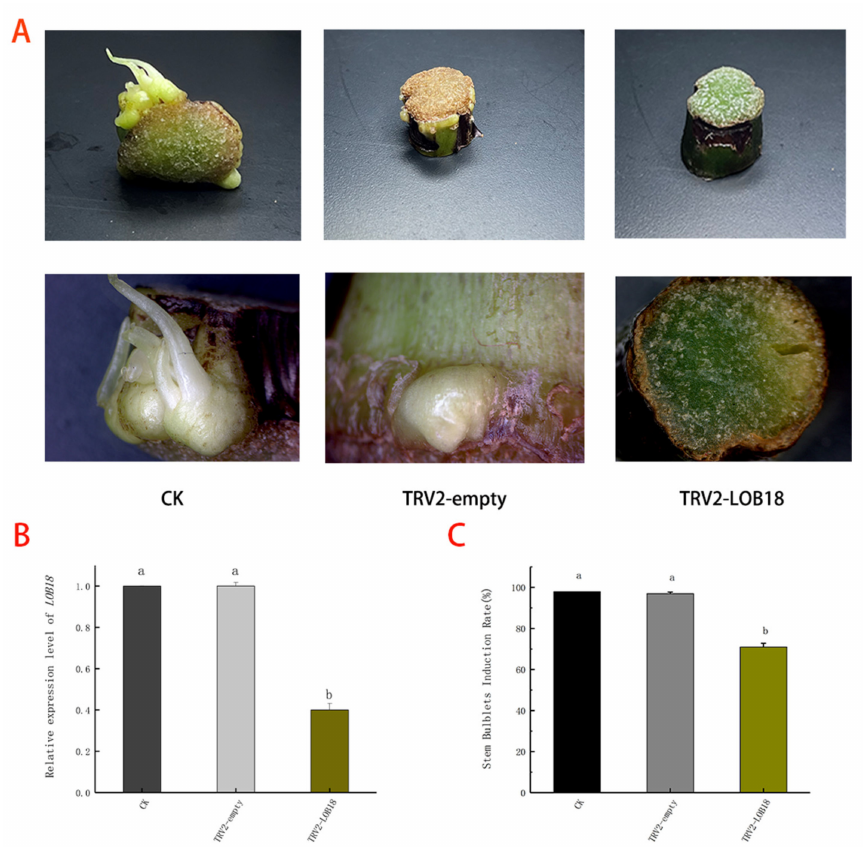
Figure 7. ( A ) The phenotype of stem segments after VIGS treatment. ( B ) Gene expression after the silencing of the LoLOB18 . ( C ) The rate of stem bulblet formation after two weeks of culture. Values are means ± SDs (n = 3). Lowercase letters (a–c) indicate statistically significant differences at p <